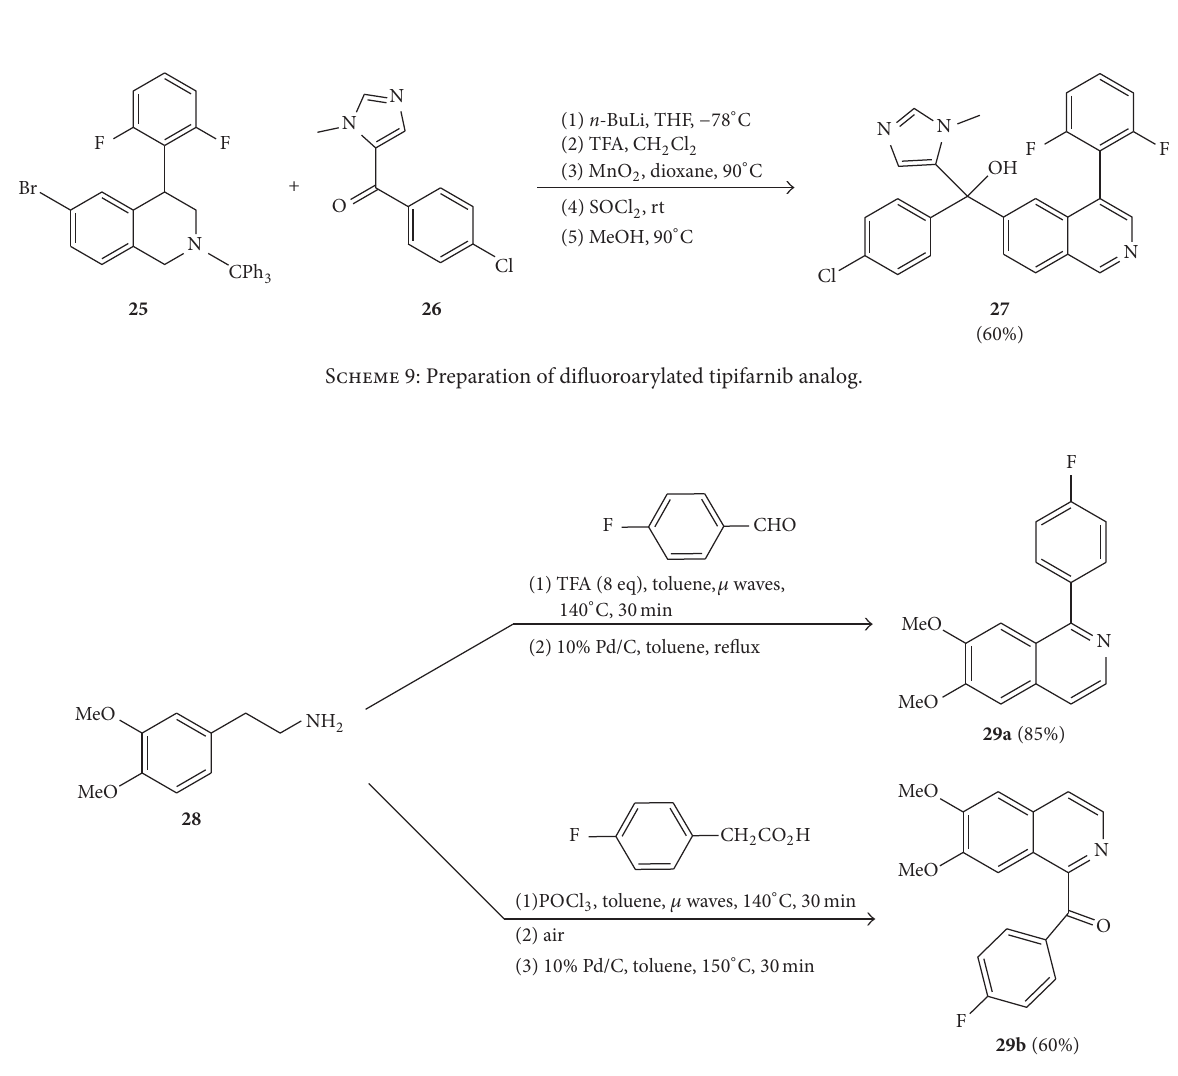
Scheme 10: Synthesis of fluorophenyl- and